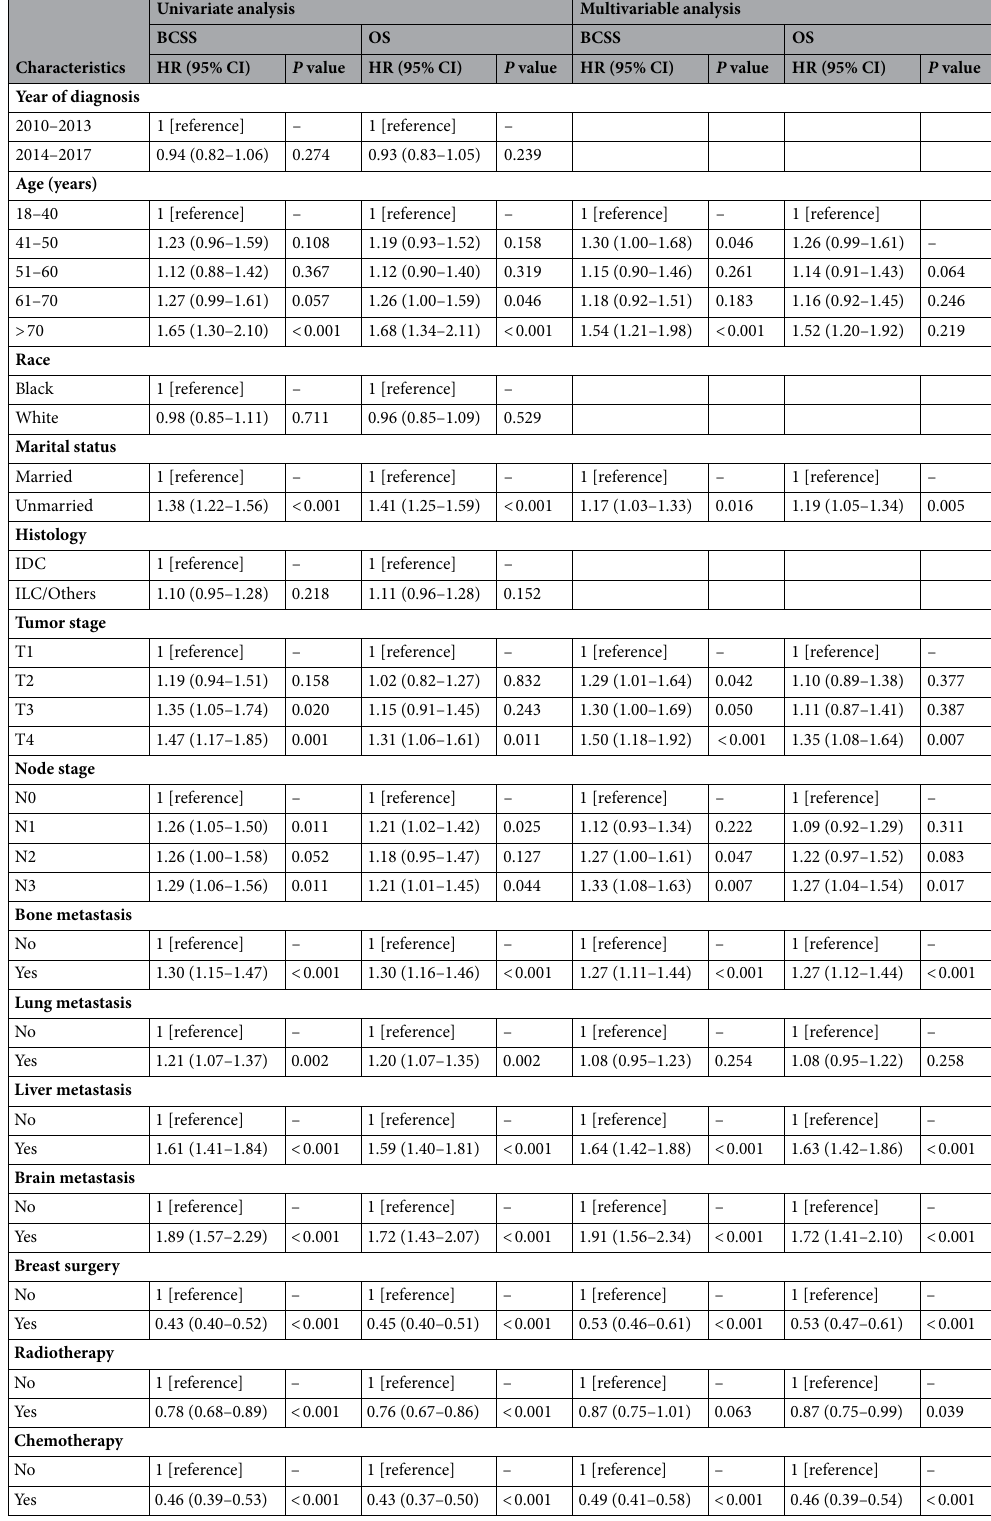
Table 3. Univariate and multivariable Cox analysis of BCSS and OS in training cohort. BCSS breast cancer- specific survival, OS overall survival, HR hazard ratio, IDC infiltrating ductal carcinoma, ILC infiltrating lobular